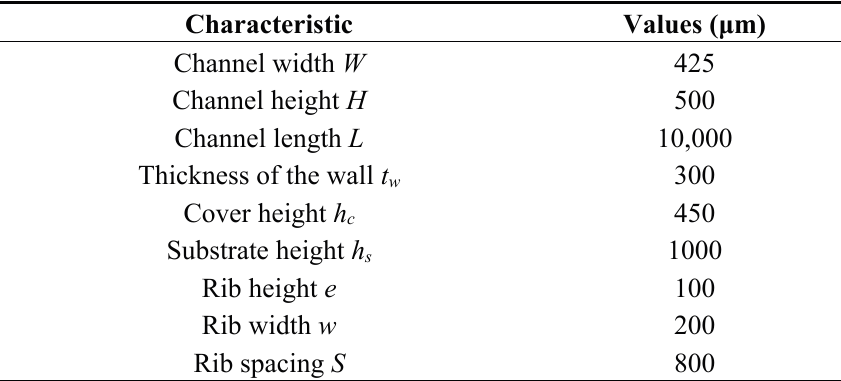
Figure 2. ( a ) The rectangular ribbed microchannel; ( b ) the triangular ribbed microchannel; ( c ) the semicircular ribbed microchannel; and ( d ) the conventional smooth microchannel. Table 1. Geometry details of the